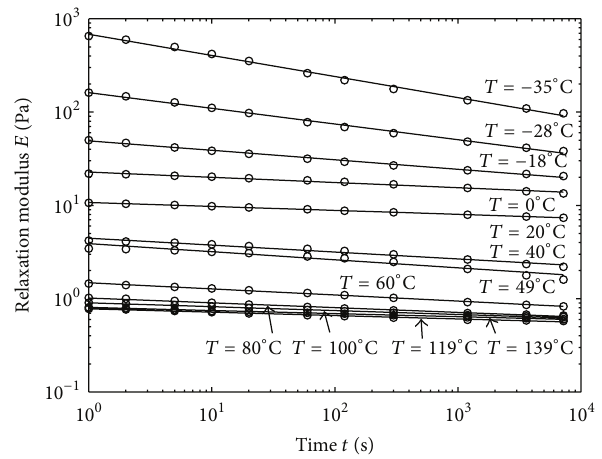
Figure 3: Relaxation modulus versus time for EVA specimens at different temperatures: experimental data (circles) and predictions by the springpot model based on fractional calculus (continuous lines).